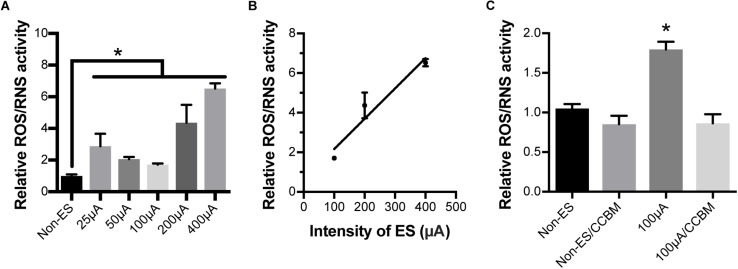
Electrical stimulation increased ROS/RNS activity in cochlear explants but inhibiting calcium influx completely abolished this effect. (A) ROS/RNS activity of explants under 25, 50, 100, 200, and 400 μA ES for 48 h was significantly higher than that of non-ES explants. ∗P < 0.05 when compared with non-ES group, n = 3 in each group, measurements were repeated three times. (B) ROS/RNS activities increased in an ES intensity-dependent manner. Pearson’s test, r = 0.9691, P = 0.1587 (two-tailed). (C) When 100 μA/48 h ES-treated cochlear explants were also treated with CCB mixture (CCBM), the level of ROS/RNS activity was comparable to that in non-ES explants. ∗p < 0.001 when compared with any other group, n = 3 in each group, measurements were repeated three times. Data represented the mean + SEM.